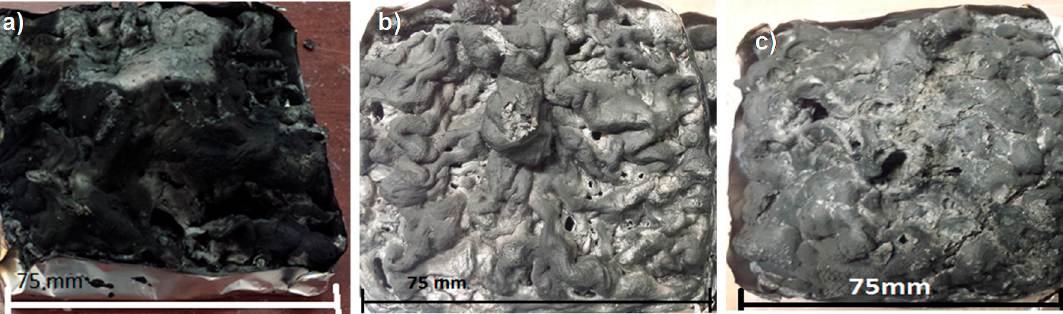
Figure 8. Photographic comparison of intumescent chars formed after cone exposure from ( a ) PVPA, ( b ) PVPA/1% MgO, and ( c ) PVPA/5% CaSiO 3 coatings on PMMA.